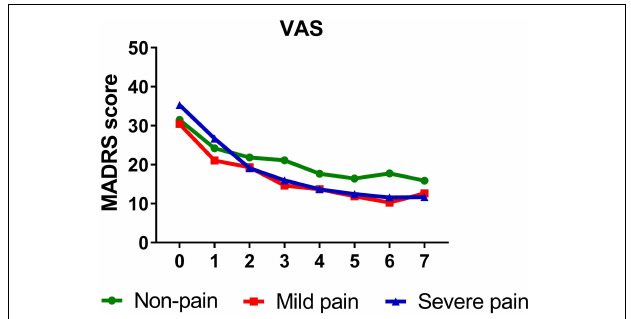
FIGURE 4 | Overall change in MADRS score across six infusions. Pain severity was defined by affective index. Patients exhibiting no pain symptom were characterized as “non-pain,” patients exhibiting the mean or below the mean affective index were characterized as “mild pain” and patients exhibiting above the mean affective index were characterized as “severe pain.” MADRS, Montgomery-Åsberg Depression Rating Scale. Numbers on X -axis: 0 represents baseline, 1 ∼ 6 represent the next morning after each infusion, 7 represents 2 weeks after infusions (Day 26).